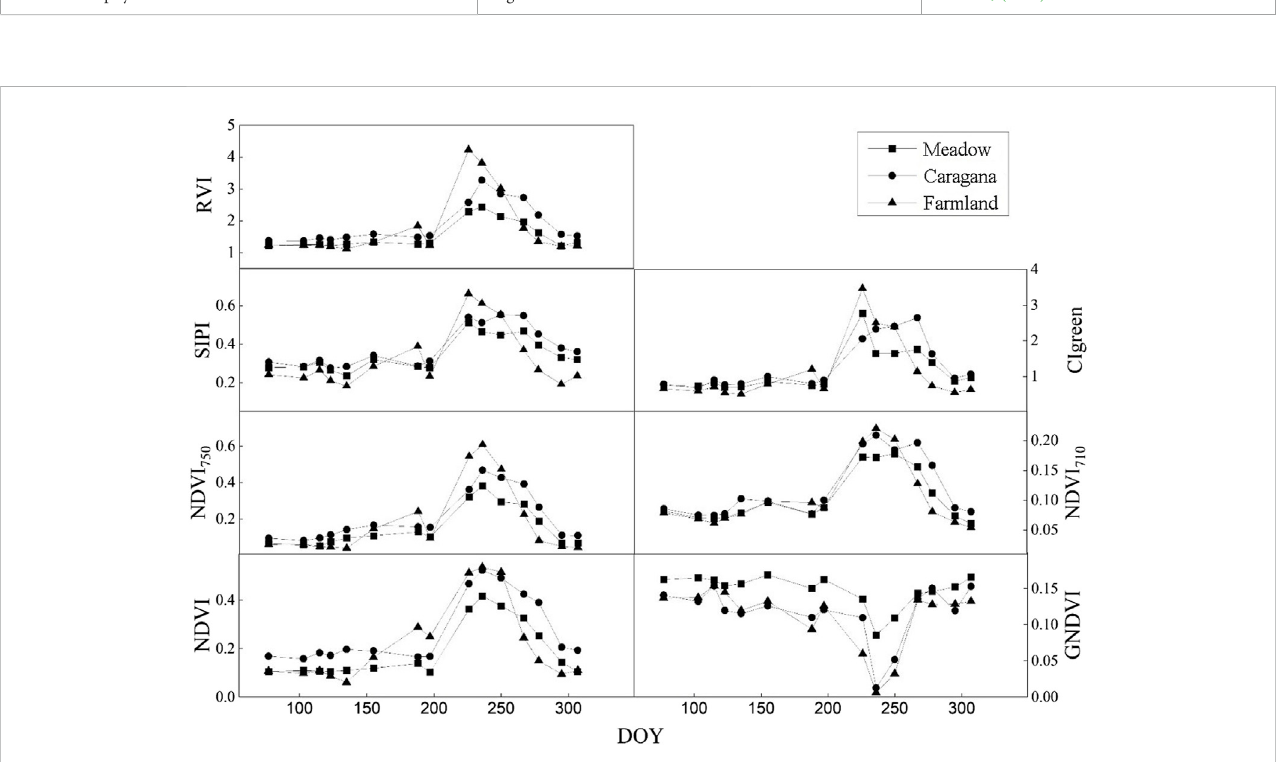
FIGURE 3 Time series change chart of vegetation indices in